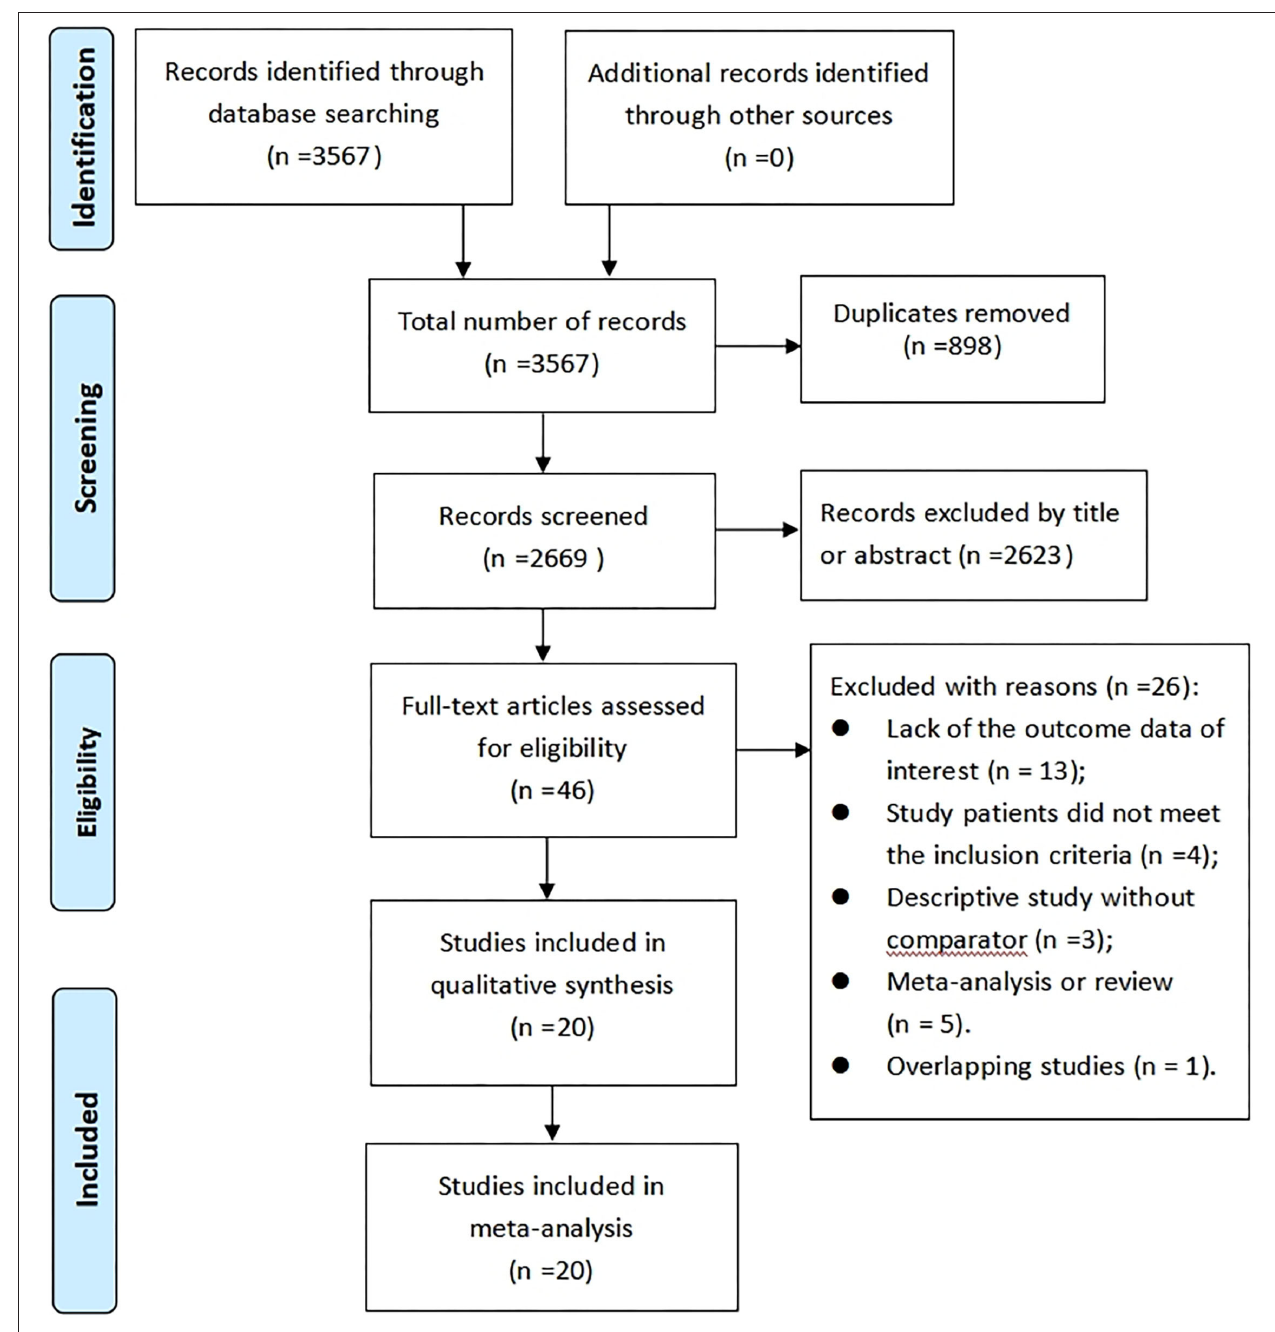
FIGURE 1 | PRISMA flowchart of study selection process.